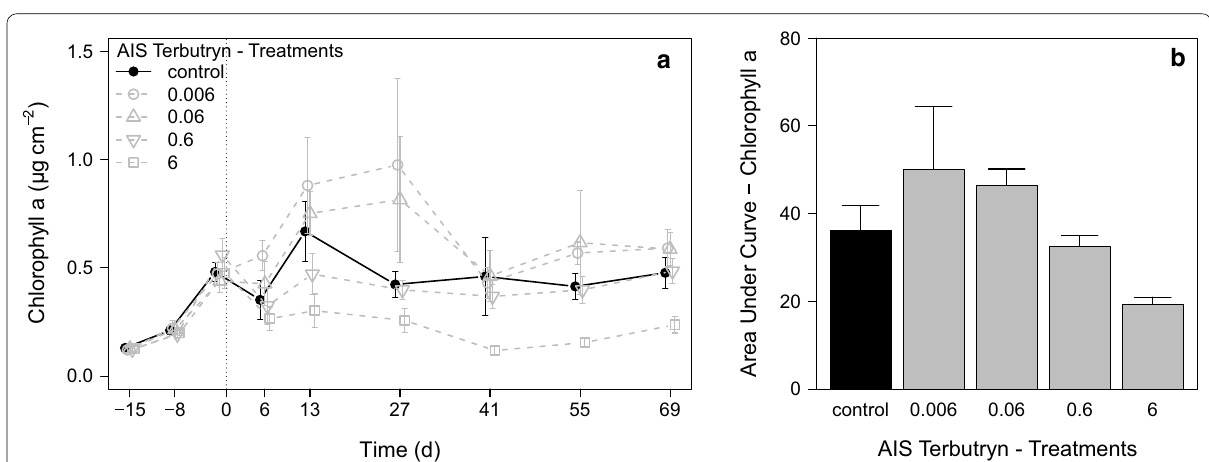
Fig. 3 a Development of aufwuchs chlorophyll a content during the the terbutryn experiment in the different treatments [mean d pre-application period, d 0 − − 1 terbutryn treatments in µg L − 1